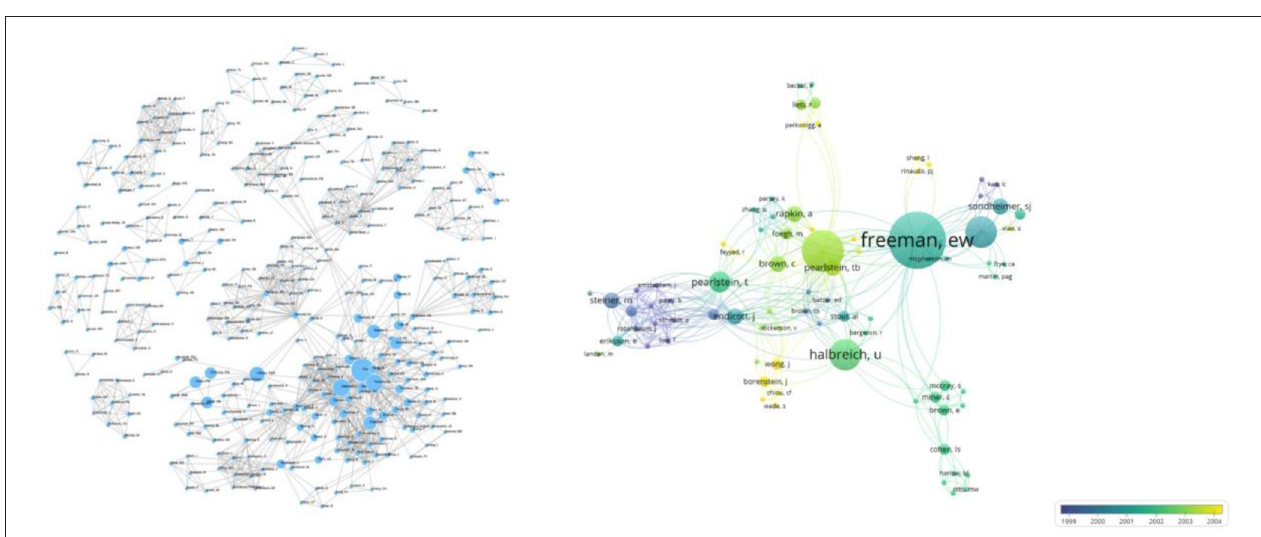
FIGURE 4 | Networks showing interconnectivity among co-authors across the 100 most cited articles according to the average published year. Size of the circles indicate the number of articles in the 100 most cited list, while the width of the curved line represents the link strength. The distance between two authors indicates approximate relatedness among the